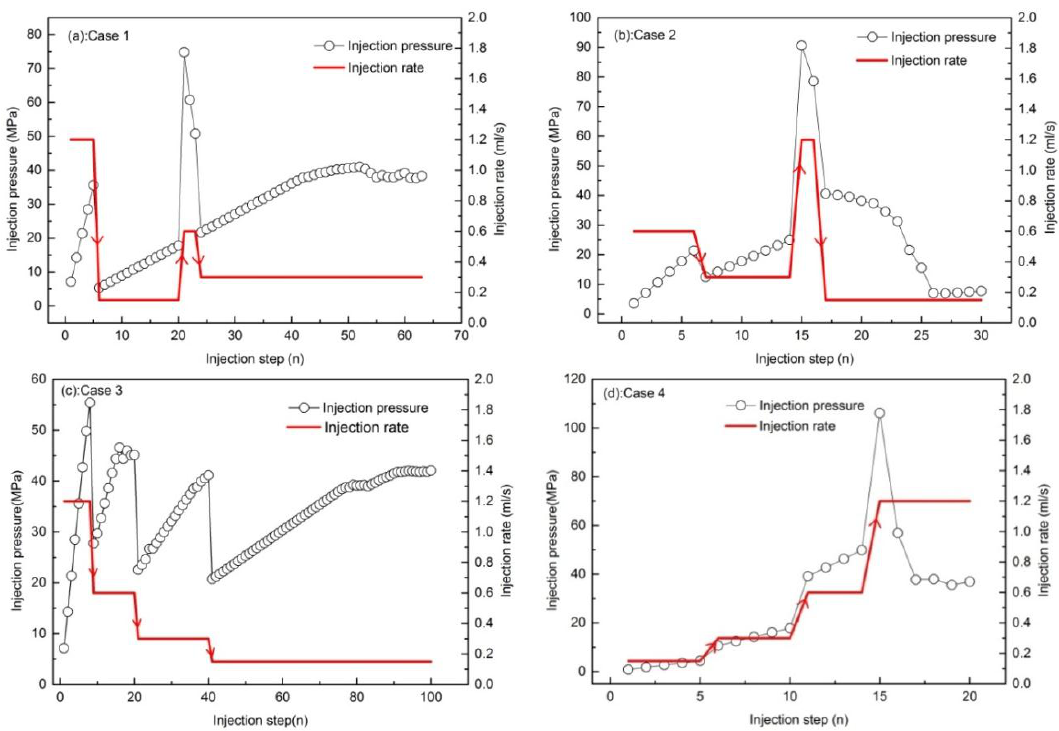
Figure 5. Relationship of injection pressure, injection step and injection rate for the studied case: ( a ) variation of injection rate is 1.2 mL/s → 0.15 mL/s → 0.6 mL/s → 0.3 mL/s; ( b ) variation of injection rate is 0.6 mL/s → 0.3 mL/s → 1.2 mL/s → 0.15 mL/s; ( c ) variation of injection rate is 1.2 mL/s → 0.6 mL/s → 0.3 mL/s → 0.15 mL/s; and ( d ) variation of injection rate is 0.15 mL/s → 0.3 mL/s → 0.6 mL/s → 1.2 mL/s).